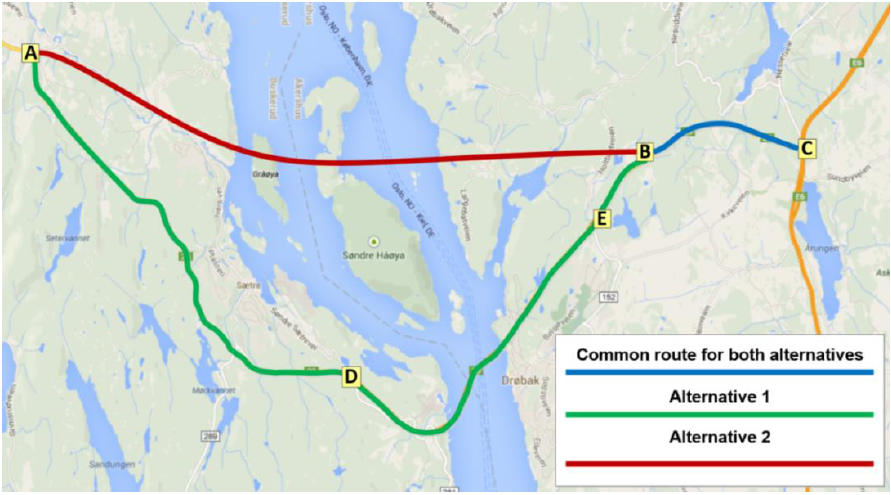
Figure 3. Oslo fjord crossing alternatives (adapted from Statens Vegvesen, 2014a) The total distance of new constructions in Alternative 1 is 13,282 metres with a total one-way